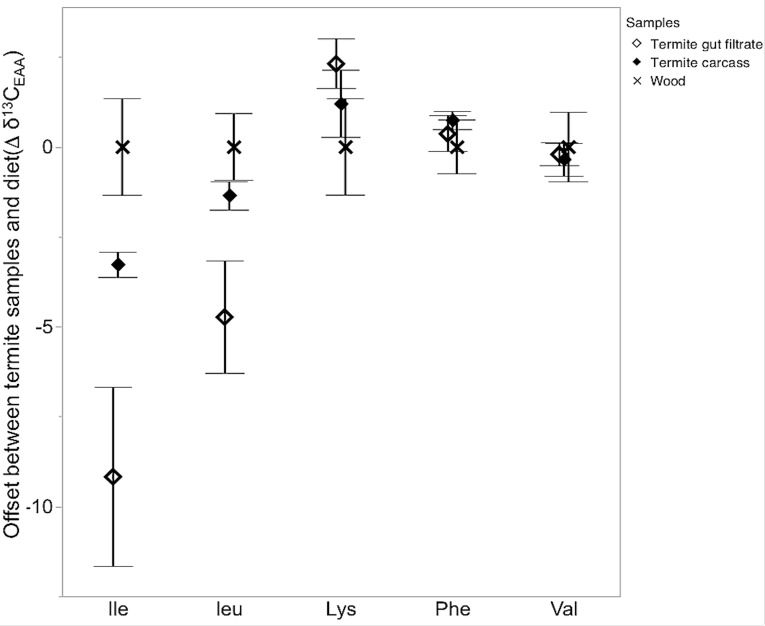
δ13C-offset between termite samples and wood diet.δ13C-offset (Δδ13CEAA) (enrichment or depletion) of 5 five essential amino acids (EAAs) in termite carcass (termites) and termite gut filtrate samples relative to the wood diet EAAs; Δδ13CEAA(‰) = (δ13CTermiteEAA–δ13CWood EAA). (F(2,63) = 6.2, P < 0.004). Shown are mean values for 5 replicates per termite sample (termite and termite gut filtrate) and 4 replicates for wood diet. The EAAs were isoleucine (Ile), lysine (Lys), phenylalanine (Phe), and valine (Val). Error bars represent standard errors of the mean.